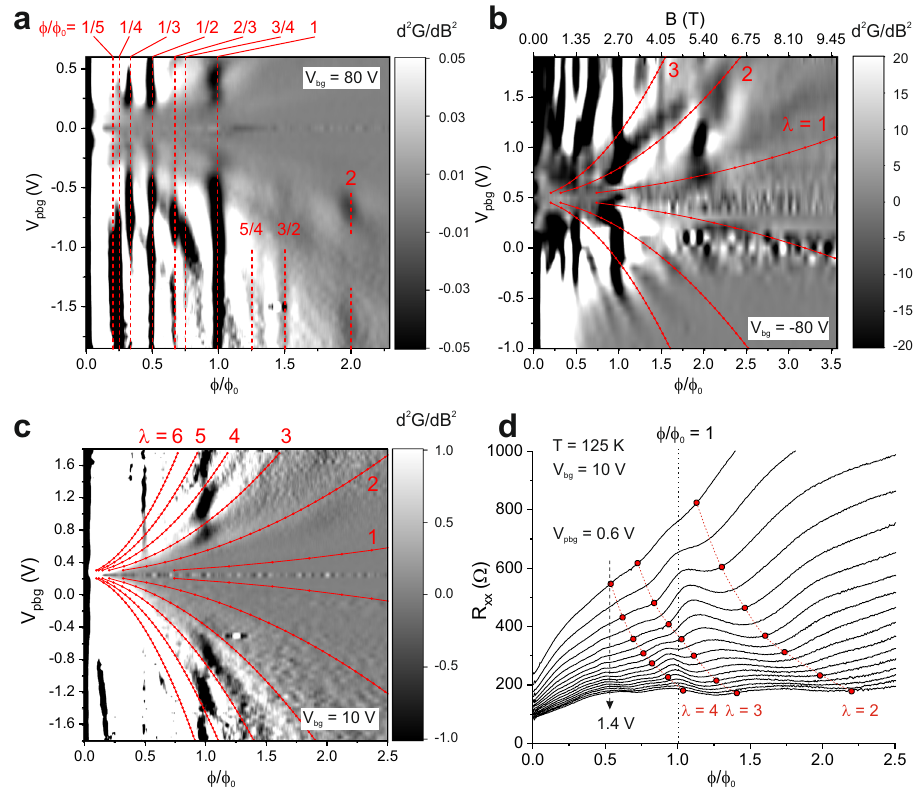
Fig. 4 Coexistence of Brown – Zak (BZ) and Weiss oscillations (WO). a Gray scale plot of the second derivative of the conductance d 2 G / dB 2 as a function of magnetic fl ux ϕ / ϕ 0 and patterned bottom gate voltage V pbg at a back gate voltage V bg = 80 V. Band conductivity/Brown – Zak oscillations are mainly visible in the bipolar regime. Observed features at rational fractions of the magnetic fl ux quantum are highlighted with red dashed lines and labelled with the corresponding value of ϕ / ϕ 0 . Also, weak features at ϕ / ϕ 0 > 1 can be observed. b Gray scale plot of d 2 G / dB 2 as a function of ϕ / ϕ 0 and V pbg at V = − 80 V. By inverting the polarity of the back gate voltage the features are mirrored with respect to the charge neutrality point. The localized feature bg at ϕ / ϕ 0 = 2 lies between fl at band positions with λ = 1 and λ = 2. c Gray scale plot of d 2 G / dB 2 as a function of ϕ / ϕ 0 and V pbg at V bg = 10 V. Reduction of band conductivity oscillations at smaller back gate voltage, i.e. weaker potential modulation. A suppression of the most pronounced feature at ϕ / ϕ 0 = 1 can be observed whenever the fl at band condition for λ = 1, 2, … , 6 is ful fi lled. d Longitudinal resistance R xx at V bg = 10 V and V pbg = 0.6 V … 1.4 V in 0.05 V steps. In contrast to Fig. 3 (a), the BZ features are much weaker. Instead, WO are visible, governed by the fl at band conditions (given by red dots; red lines are guides to the eye), but only appear clearly at BZ maxima positions, modulating the BZ feature at ϕ / ϕ 0 = inverse fl ux, ϕ 0 / ϕ , in other words unit fractions of the fl ux ϕ / ϕ 0 , the Hofstadter spectrum has the full width of the underlying Landau bands 8,26 (See Fig. 1b at ϕ 0 / ϕ = 0 or 1). Therefore, the band conductivity is as large as permitted by the modulation broadened Landau bands. At other inverse fl ux values ϕ 0 / ϕ = q / p with small p , e.g. 1/3 or 2/3, there are still sizable subbands in the Hofstadter-split Landau bands, which are also re fl ected as visible conductivity contributions. Outside those regions, the Hofstadter spectrum is so strongly split that band conductivity is completely suppressed. As the Hofstadter spectrum only depends on the fl ux ratio, not on the density, all vertical dark lines in Fig. 4 can be traced back to this effect. To understand the density dependent modulation in the vertical lines (in particular, the ϕ / ϕ 0 = 1 line in Fig. 4c), we have to consider the fl at band condition. Depending on the fl at band condition, the width of each Landau band oscillates with magnetic fi eld, leading to an oscillating band conductivity correction 23 . For example, in Fig. 1a, we fi nd two Landau bands ( n = 6, 11), where the fl at band condition occurs very close to ϕ / ϕ 0 = 1, reducing the visibility of the corresponding conductivity peak, while other Landau bands extend to the maximum width. We note that the semi-classical formula for the fl at band condition (Eq. 2) is suf fi cient to describe the data in Fig. 4. Clearly, the visibility of the BZ oscillations is suppressed, whenever the fl at band condition is satis fi ed.